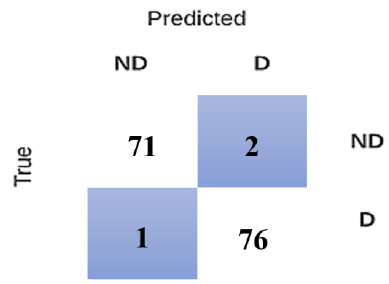
Figure 4. Confusion matrix outcome of the hybrid model (D: Demented; ND: Non demented).